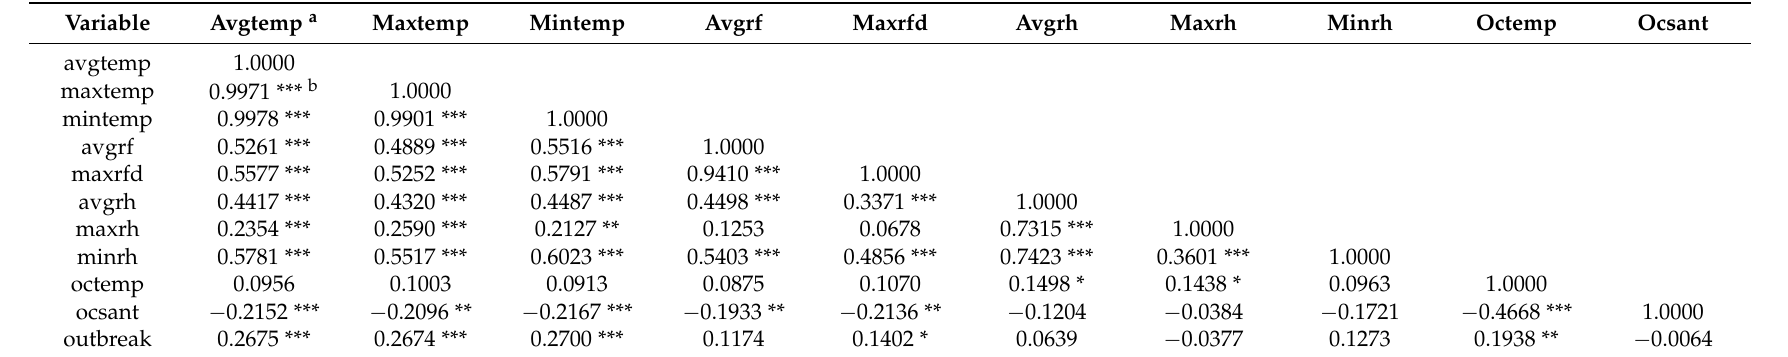
Table 2. Pearson correlation coefficients between variables, N =